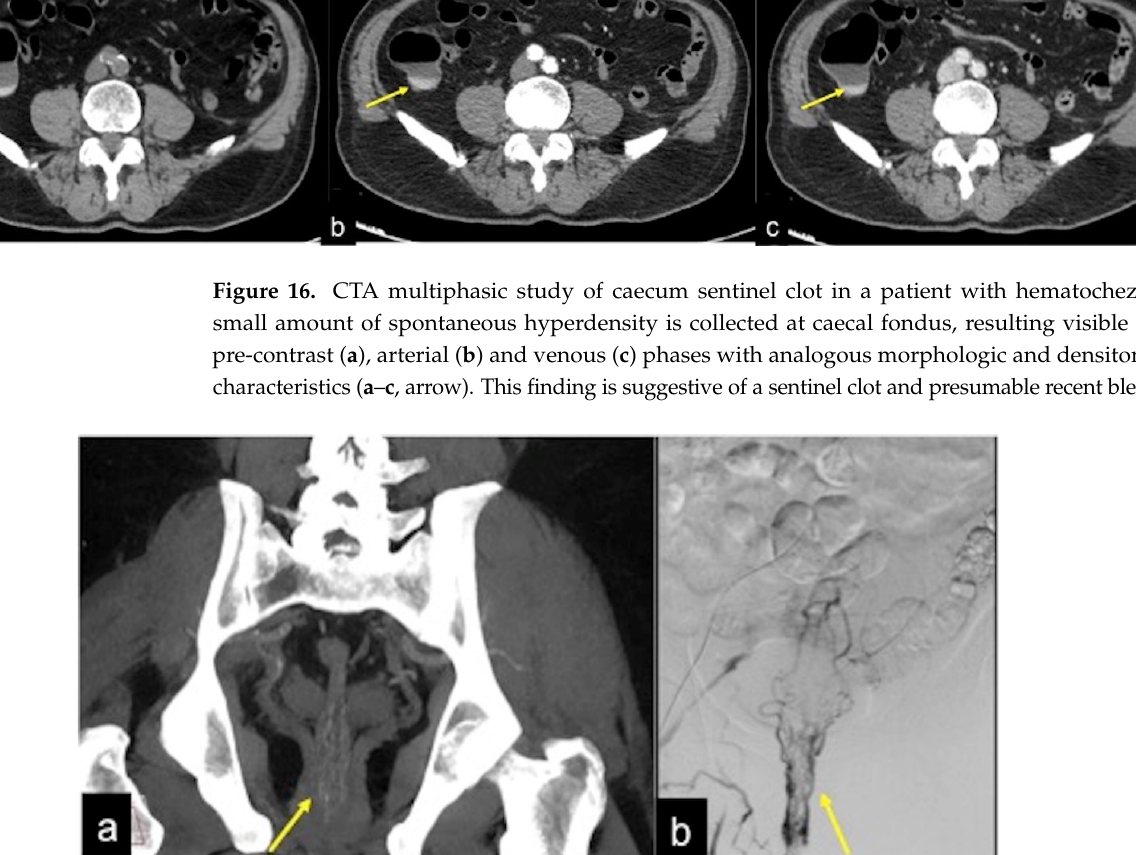
Figure 17. MIP reconstruction of arterial phase ( a ) and angiography study ( b ) of rectal artero-venous malformation. The anatomic detail is very similar when comparing imaging of the two techniques (( a , b ) arrow).